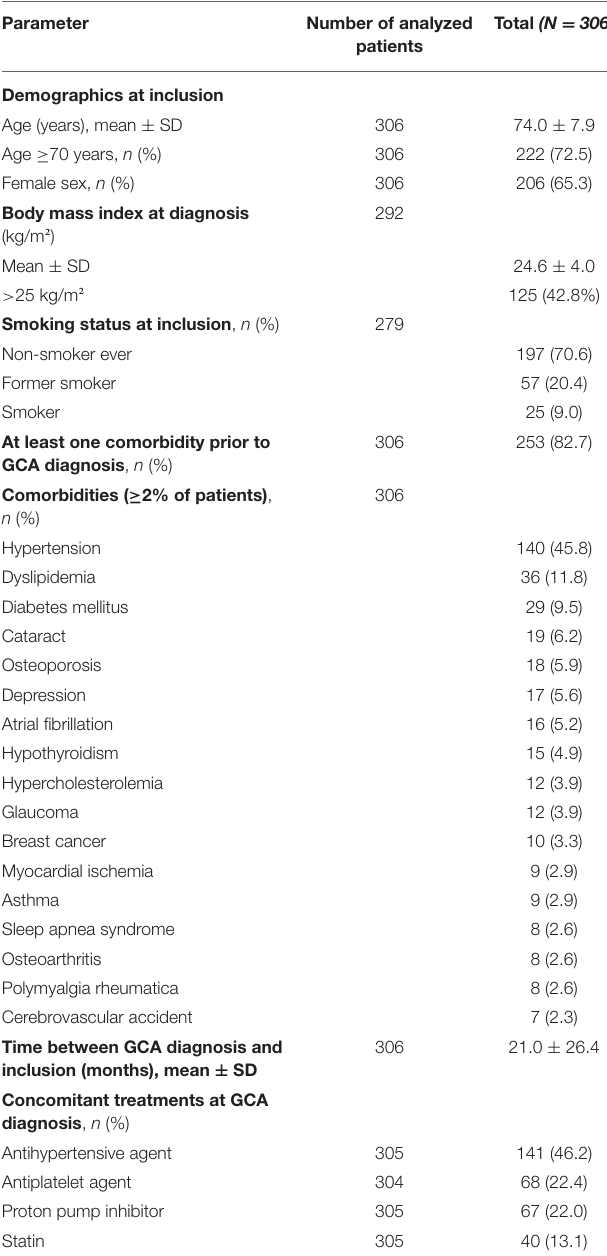
TABLE 1 | Characteristics of